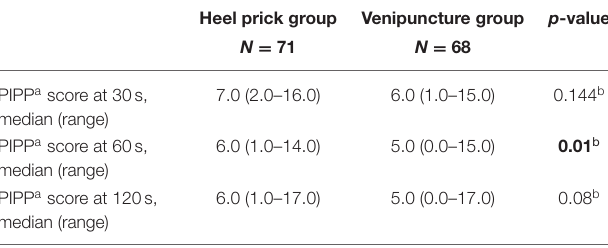
a PIPP: Premature Infant Pain Profile. b Wilcoxon rank-sum test. The bold values indicate the values which is statistically significant (p <